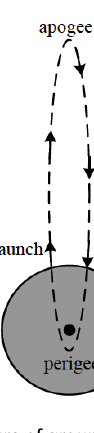
Figure 2. Suborbital feature of ground-based electromagnetic